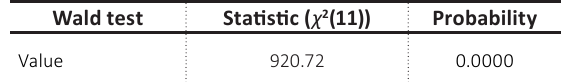
Table 12. Modified Wald test for